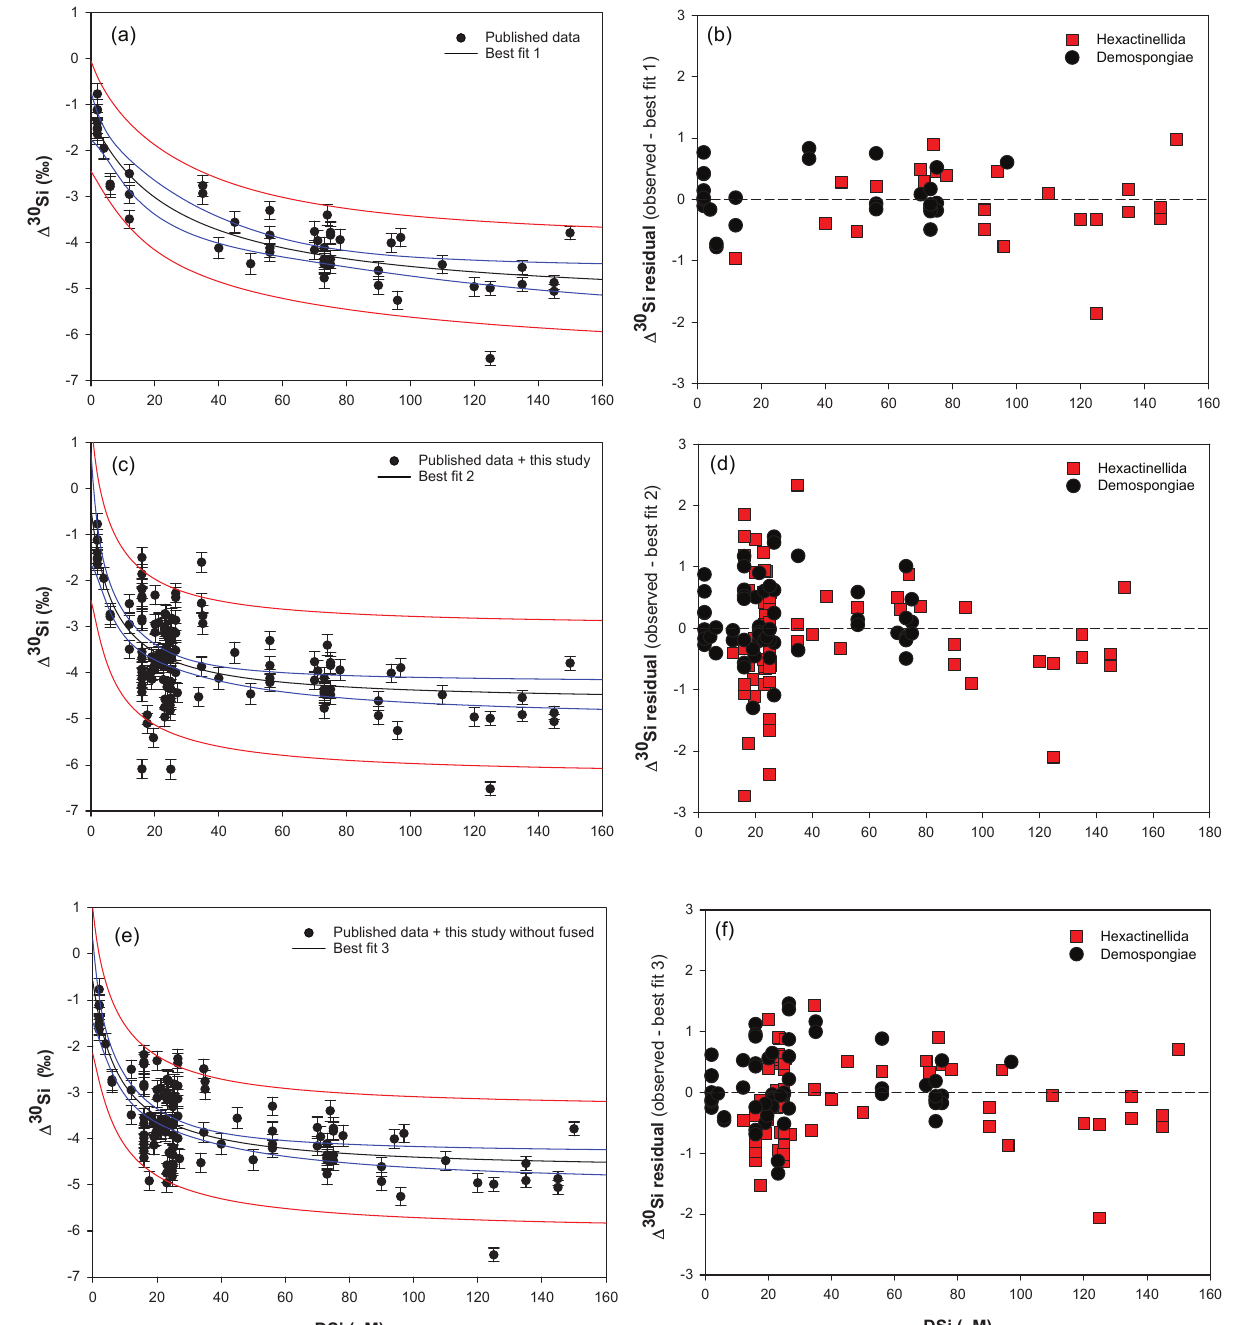
Figure 5. Plots of the best-fit model (left) and the corresponding δ 30 Si residual (right) of Hexactinellida (red squares) and Demospon- giae (black circles). (a) Best fit ( δ 30 Si =− 5.39(0.4) + 111.51(11.3) / (26.87(11.2) + DSi)) and (b) residual from Hendry and Robinson (2012), Wille et al. (2010), and Hendry et al. (2010) data. (c) Best fit ( δ 30 Si =− 4.69(0.2) + 30.89(2.7) / (7.29(2.7) + DSi)) and (d) resid- ual from Hendry and Robinson (2012), Wille et al. (2010), and Hendry et al. (2010) with the equatorial Atlantic data (JC094). (e) Best fit ( δ 30 Si =− 4.71(0.18) + 34.25(2.6) / (8.29(2.6) + DSi)) and (f) residual from Hendry and Robinson (2012), Wille et al. (2010), and Hendry et al. (2010) with the equatorial Atlantic (JC094) without the fused spicules (F2 to F5). For best-fit model plots, black lines show the best-fit regression, blue lines the 95% confidence interval and red lines the 95% prediction interval, and for the best-fit equation, the numbers in parentheses are the standard error. NB, best fits 2 and 3 and their corresponding residual tests were calculated only with identified sponge samples, which results in discrepancies between Figs. 2b and